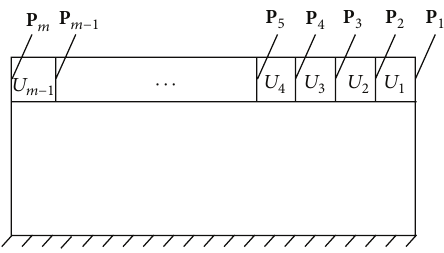
Figure 5: Milling units and tool positions.